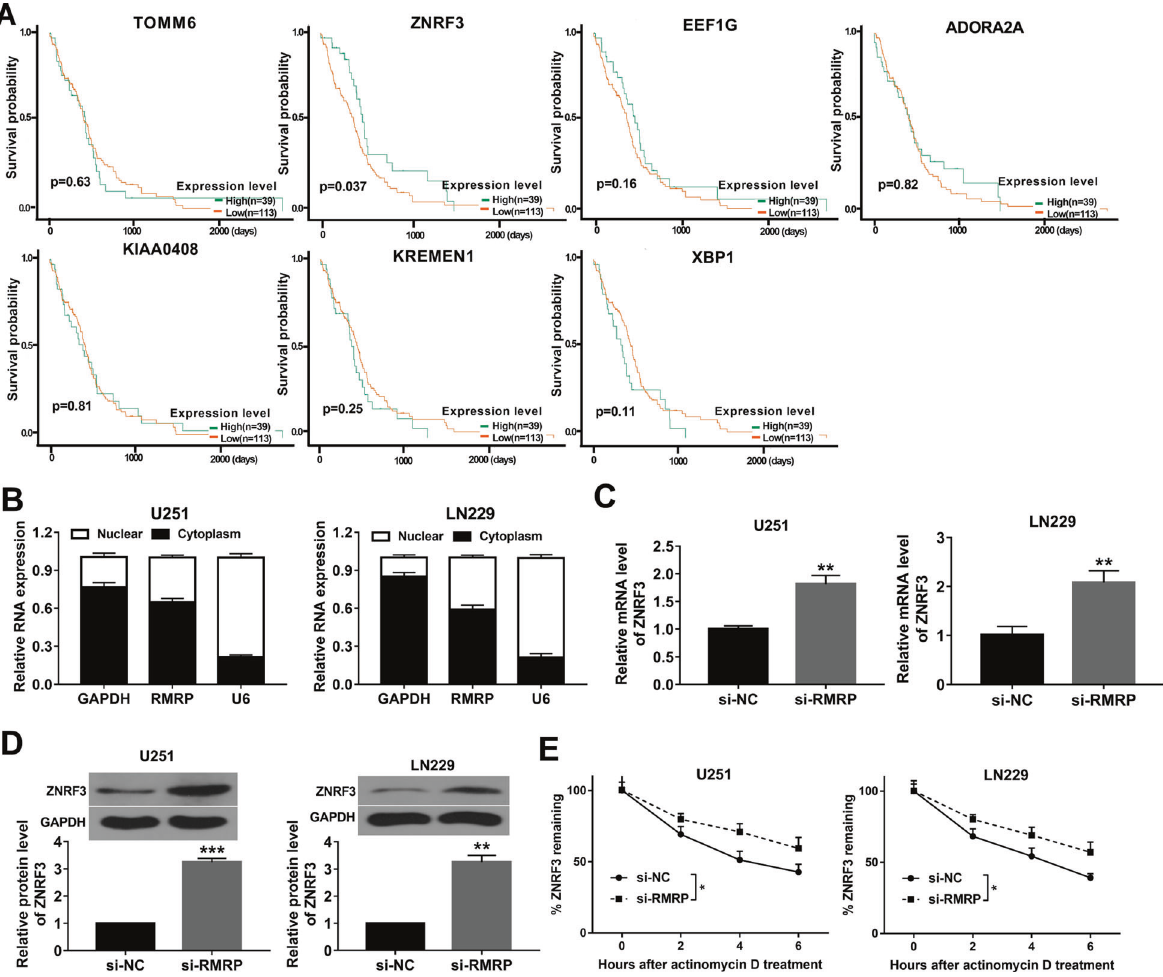
Fig. 4 ZNRF3 was a target of RMRP3. A Survival analysis of glioma patients with high or low expression of TOMM6, ZNRF3, EEF1G, ADORA2A, KIAA0408, KREMEN1, and XBP1. B RMRP level in the nucleus and cytoplasm of U251 and LN229 cells was measured by RT-qPCR assay after the isolation of nuclear and cytoplasmic RNA ( n = 3). C , D The effects of RMRP knockdown on ZNRF3 mRNA and protein expression were measured by RT-qPCR and western blot assays at 48 h after transfection in U251 and LN229 cells ( n = 3). E The effect of RMRP knockdown on ZNRF3 mRNA stability was examined through ActD and RT-qPCR assays in U251 and LN229 cells ( n = 3). ** P <